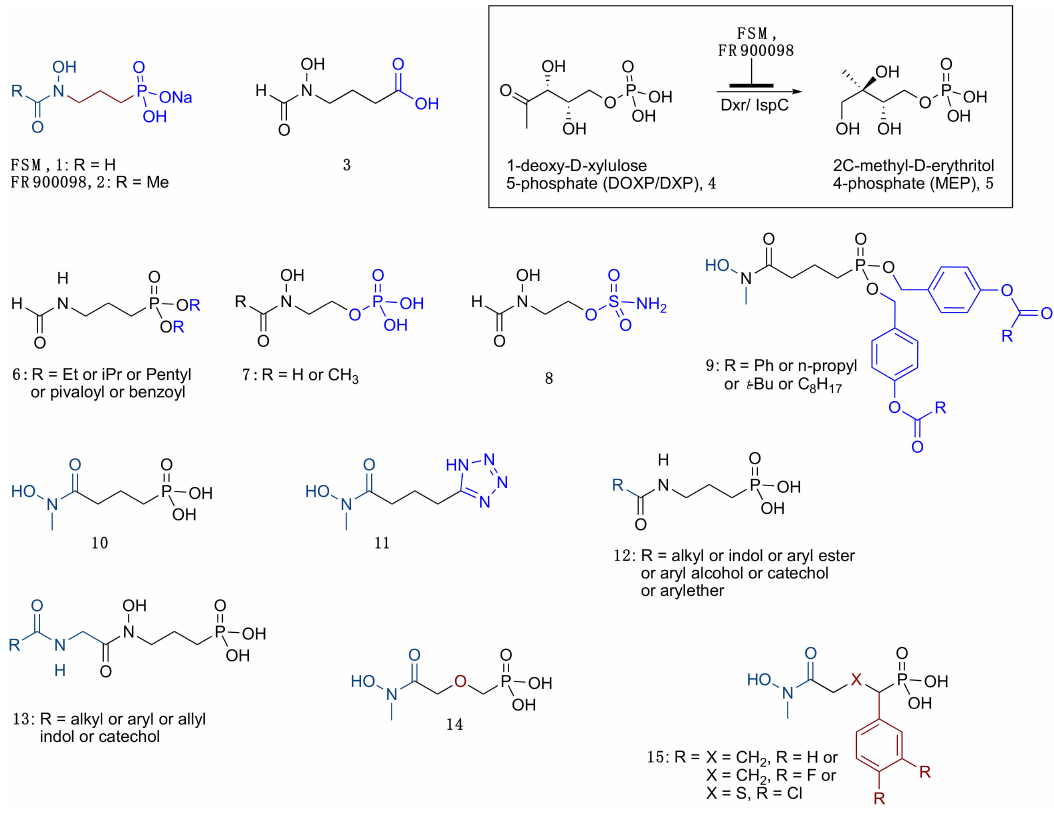
Figure 1. Structures of FSM, FR9000098, and various FSM